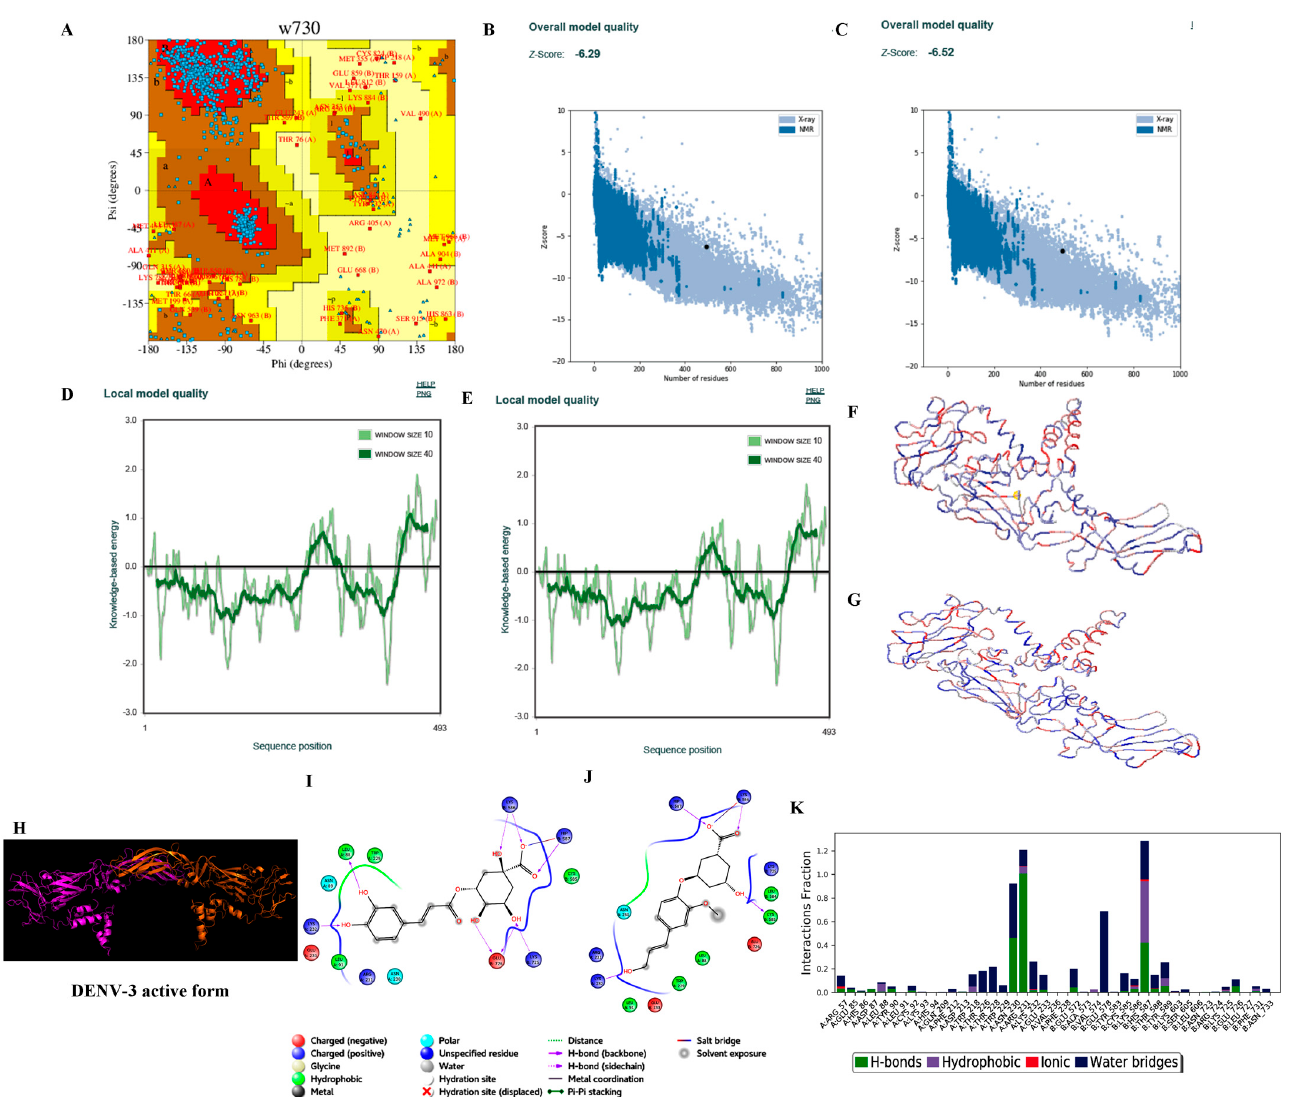
Figure 4. Structure validation of DENV-3 by various in silico methods. ( A ) PROCHECK analysis (Ramachandran plot of the best DENV-3 model). ( B ) Model quality before minimization (ProSA). ( C ) Model quality after minimization (ProSA). ( D ) Per residue model quality before minimization. ( E ) Per residue model quality after minimization ( F ) Ribbon form of DENV-3 structure before min- imization (blue color—least energy regions; red color—highest energy regions). ( G ) Ribbon form of DENV-3 structure after minimization (blue color—least energy regions; red color—highest energy regions). Structure of DENV-3 envelope protein and docking and dynamics interactions of reference and novel inhibitor molecules. ( H ) Cartoon representation of the best DENV-3 dimer model (A chain in magenta color and B chain in red color). ( I ) Best docked published inhibitor (Chlorogenic acid) interactions with DENV-3. ( J ) Best docked lead 1 (RGBLD-3) interactions with DENV-3; In DENV- 3, RGBLD3 showed interactions with 13 amino acids. Five bonded interactions were found compris- ing of hydrogen bonding with Lys232 of chain A; His92, Lys91, Cys90 of chain B. Salt bridge was observed in Lys91 of chain B. Non-bonding interactions include polar, hydrophobic, positive charge, and negative charge with amino acids Leu88, Trp229, Glu233, Leu91, Arg231, Asn230 of chain A; Leu89, Glu231 of chain B. ( K ) DENV-3-RGBLD-3 (protein ligand contacts) in 100 ns molec- ular dynamics simulations.